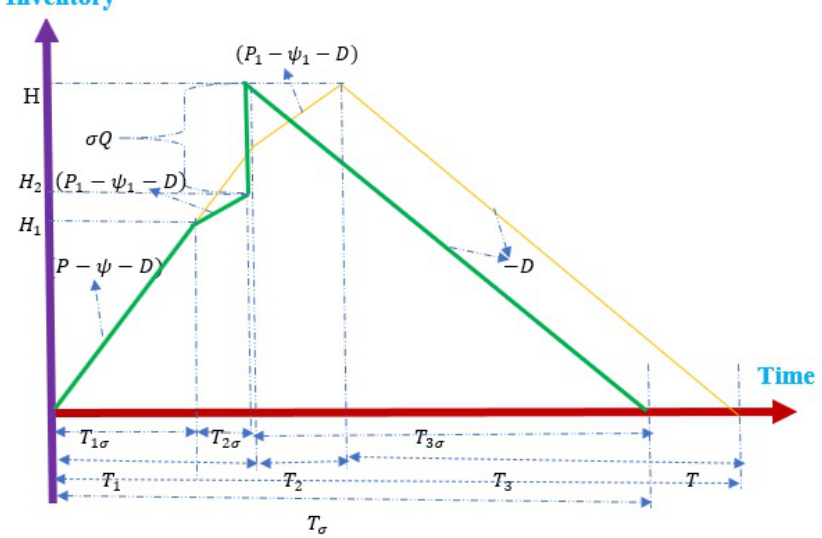
Figure 1. Comparison of status of items of perfect quality in the present system (in green) and in a system with no outsourcing option (in orange) [2] under energy-saving mode.